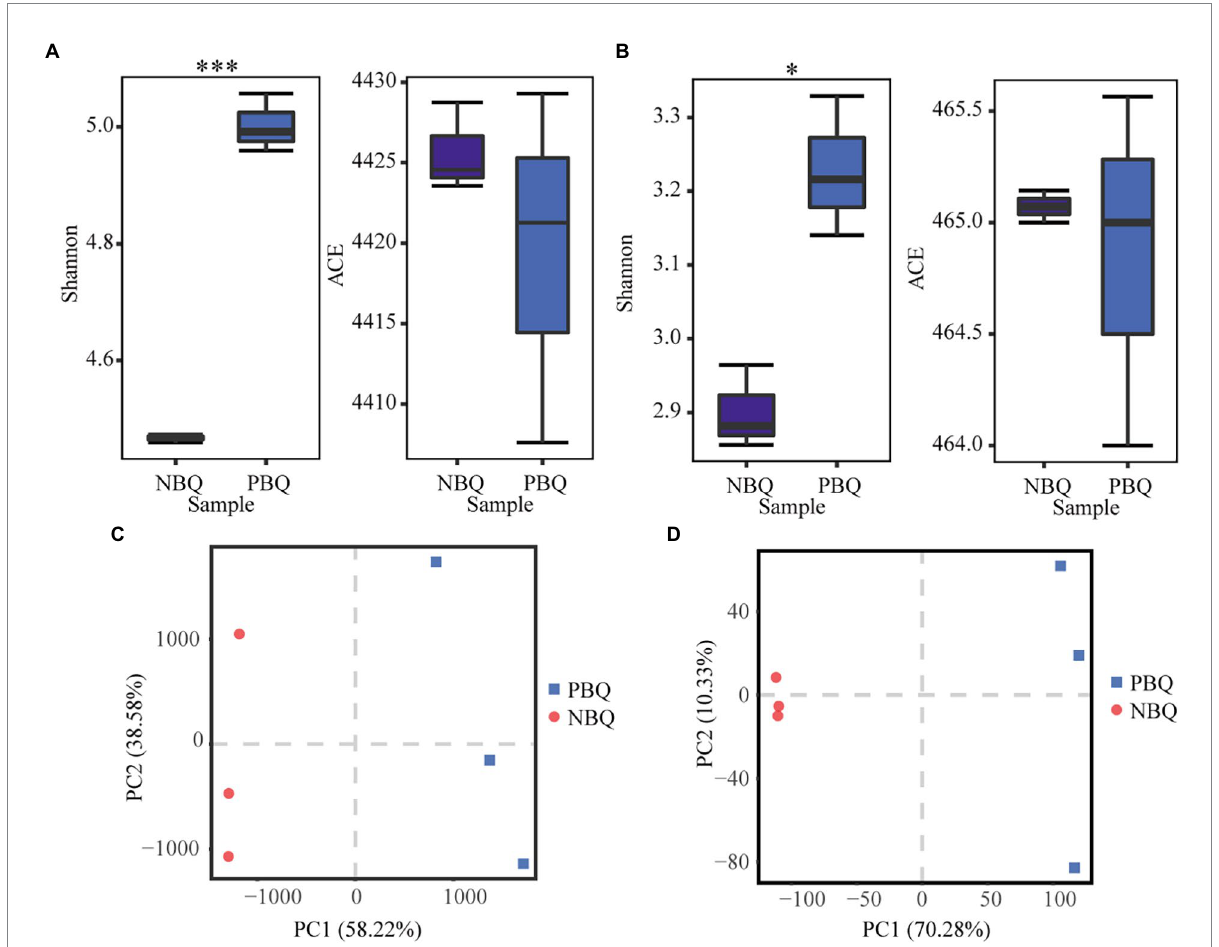
FIGURE 1 Alpha diversity analysis of bacterial community (A) and fungal community (B) of the two grades of BBQ, * p < 0.05, ** p < 0.01, *** p < 0.001 determined by ANOVA; differences in the microbial (C) and genetic (D) composition of the two grades of BBQ based on